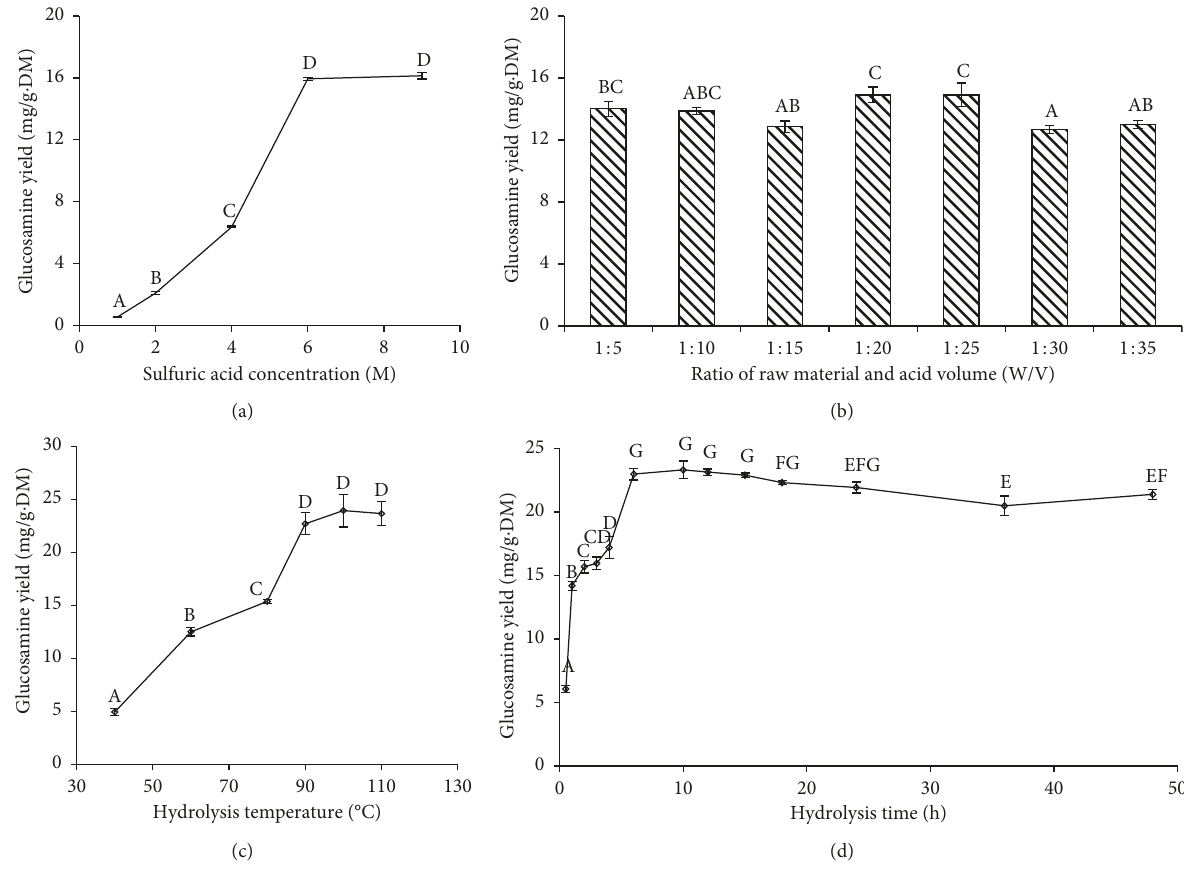
Figure 2: Effects of sulfuric acid concentration, ratio of raw material to acid volume, hydrolysis temperature, and time on glucosamine yield. (a) Sulfuric acid concentration; (b) ratio of raw material to acid volume; (c) hydrolysis temperature; (d) hydrolysis time. Shared letters indicate means that are not significantly different ( p < 0 . 05) by one-way ANOVA with post hoc Tukey’s